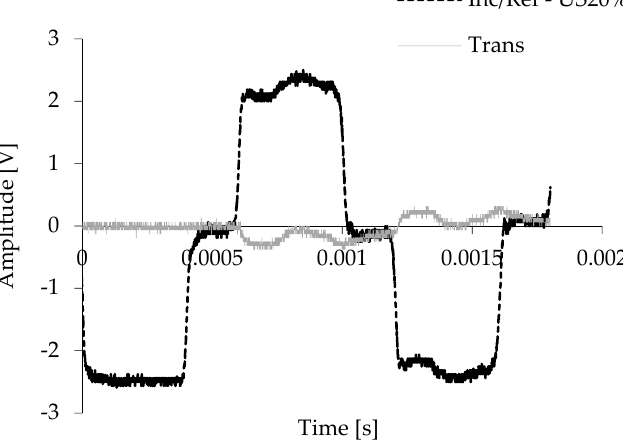
Figure 2. Typical strain signals obtained from the SHPB tests for the AlSi12-US20%.